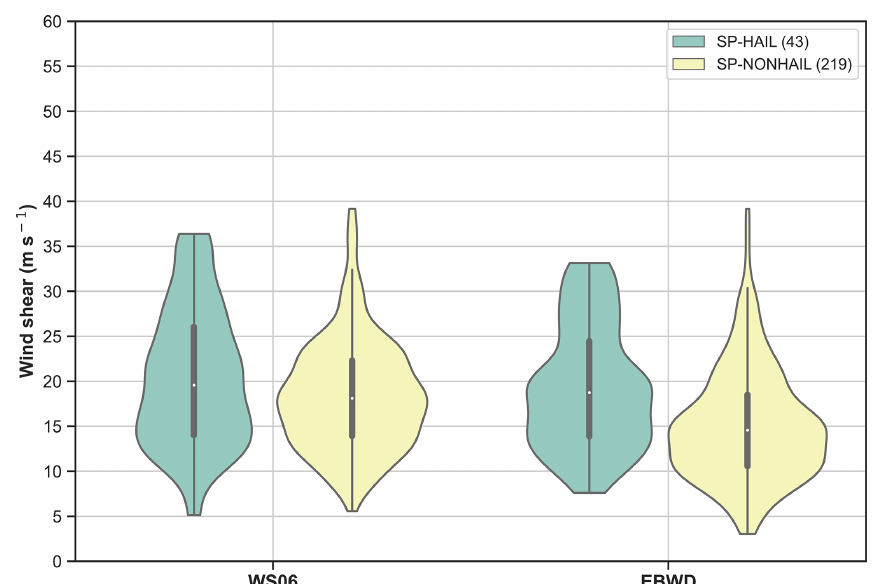
Figure 10. As in Fig. 7, but for WS06 and